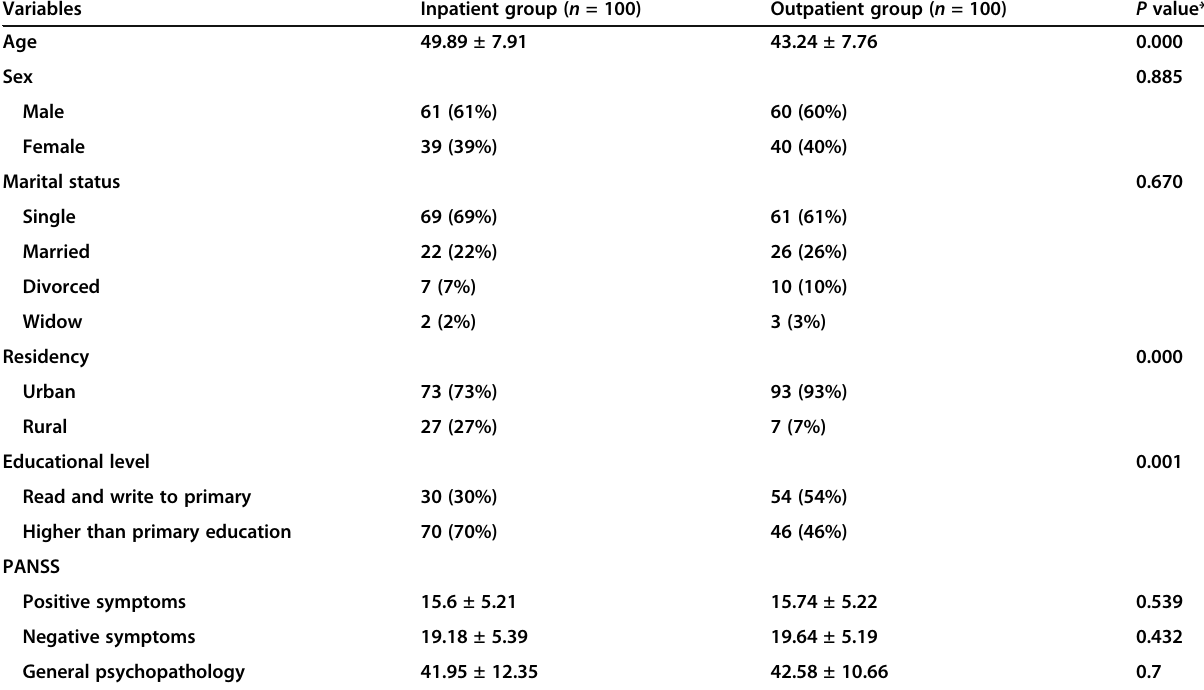
Table 1 Sociodemographic and clinical characteristics across inpatient and outpatient groups